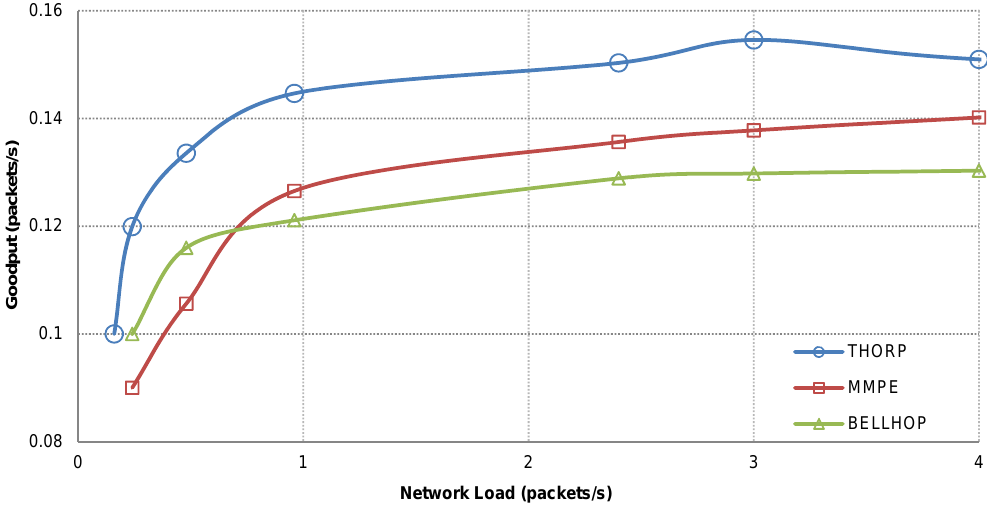
Figure 7. Average Goodput with different acoustic propagation models.